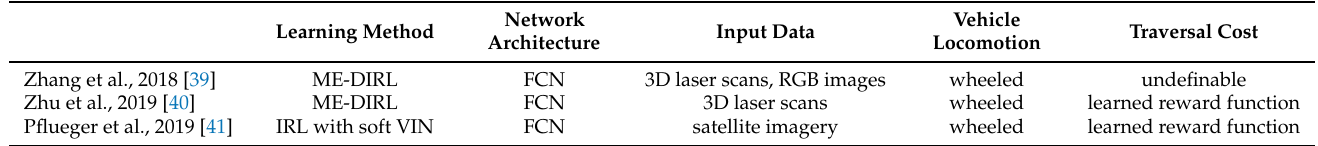
Table 2. Works on regression of traversal costs with deep